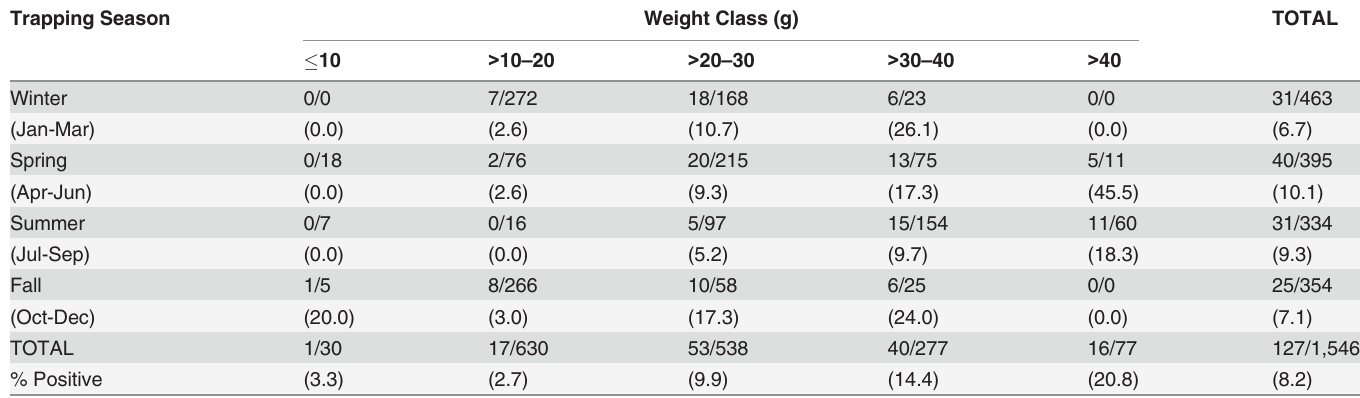
Table 2. Seasonal and total number of A . agrarius Ab+ for HTNV/ number captured by weight category (%) at Nightmare Range from 2008 – 2009. Trapping Season